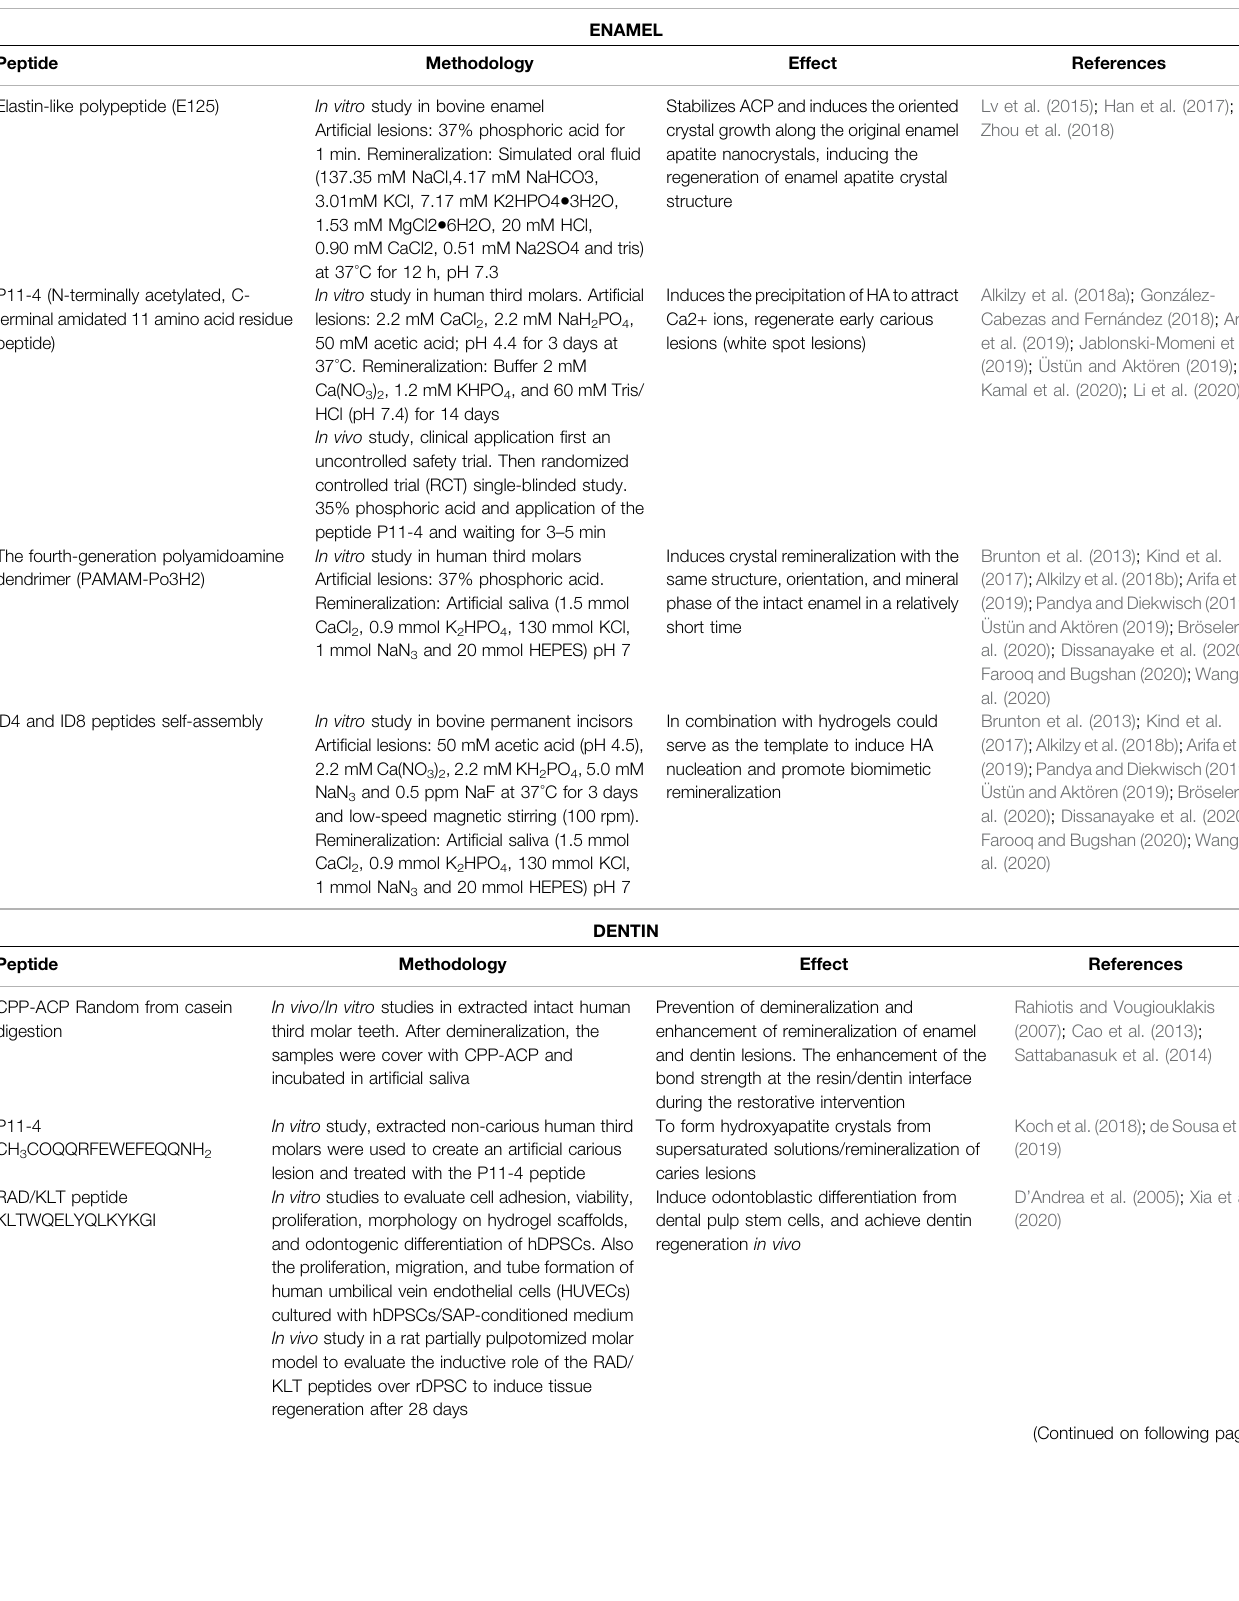
TABLE 1 | ( Continued ) Synthetic peptides used for dental tissue